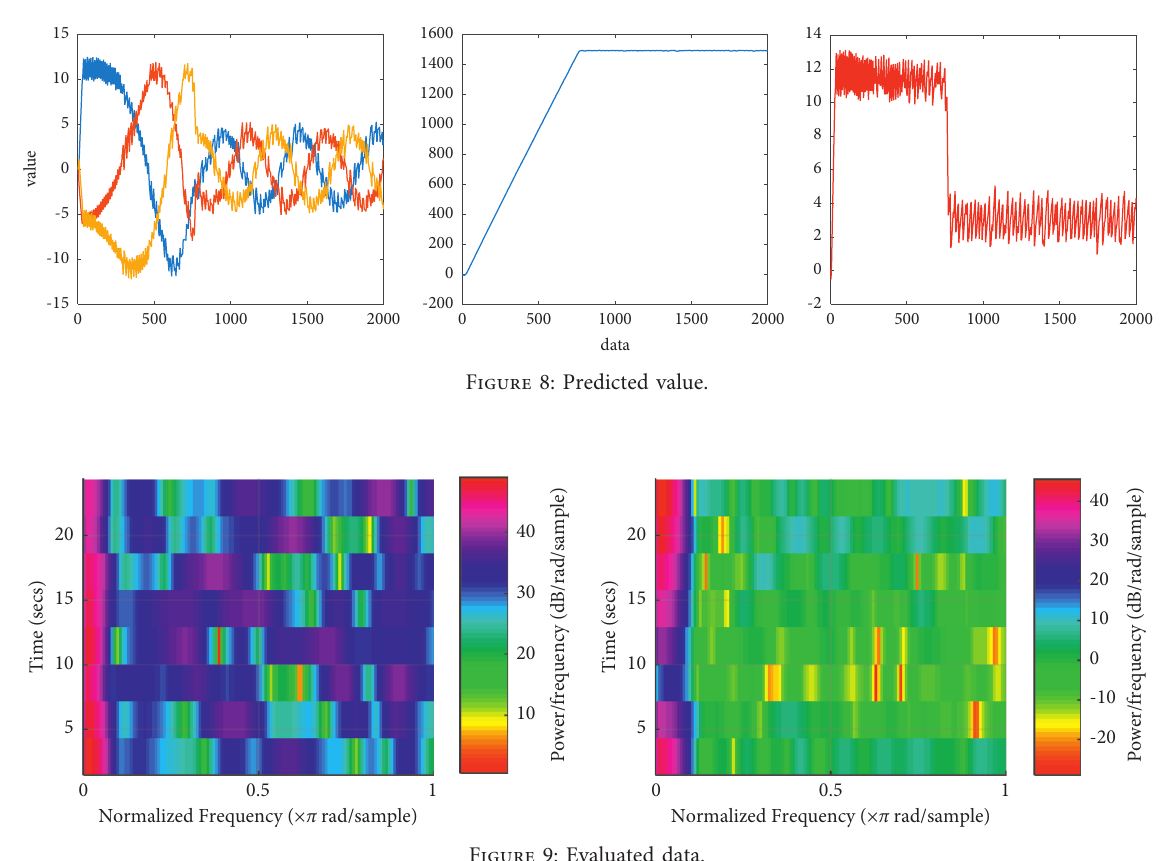
Figure 9: Evaluated data.